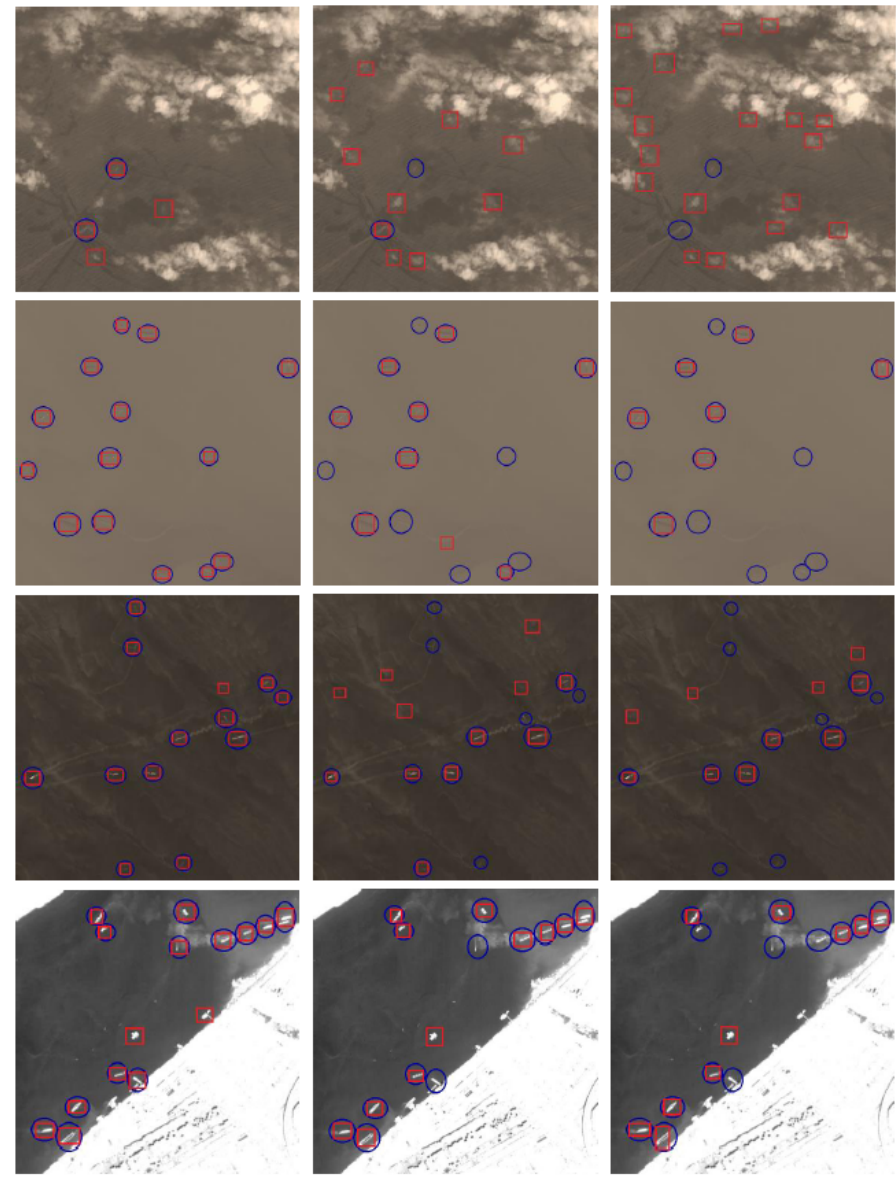
Figure 10. Comparison of target detection results in different methods under different